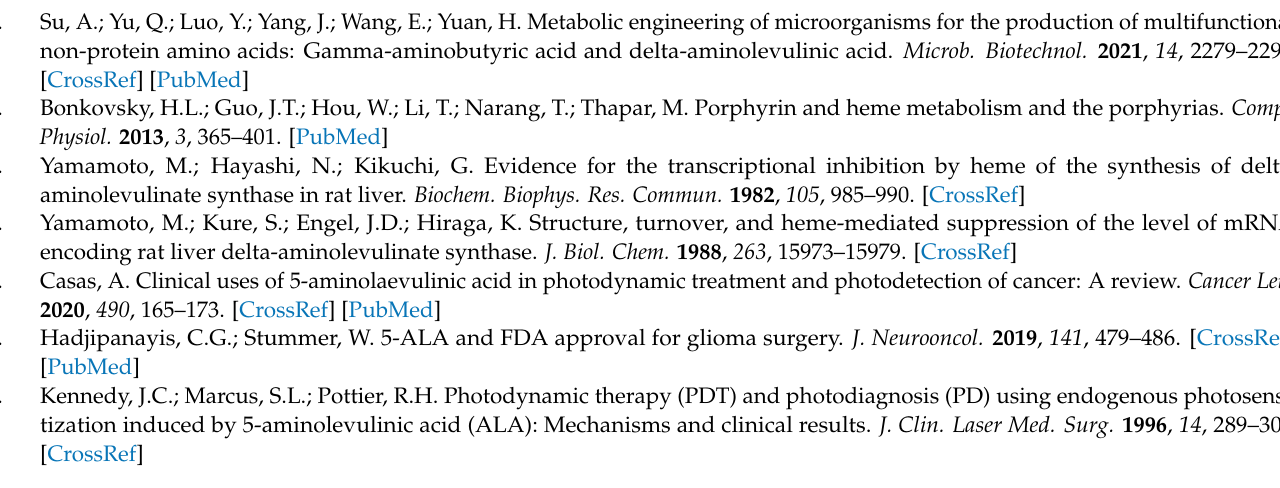
Figure S2: The publications comparison between nanomaterials related publications and photodiag- nosis/photodynamic therapy related publications; Figure S3: The second level cluster analysis